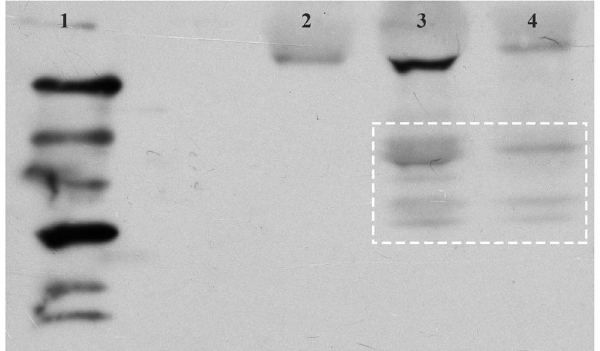
Figure 3. Cry1Ac detection (dashed square) in the egg masses of the lepidopteran Chlosynelacinia by ECL Western Blot.